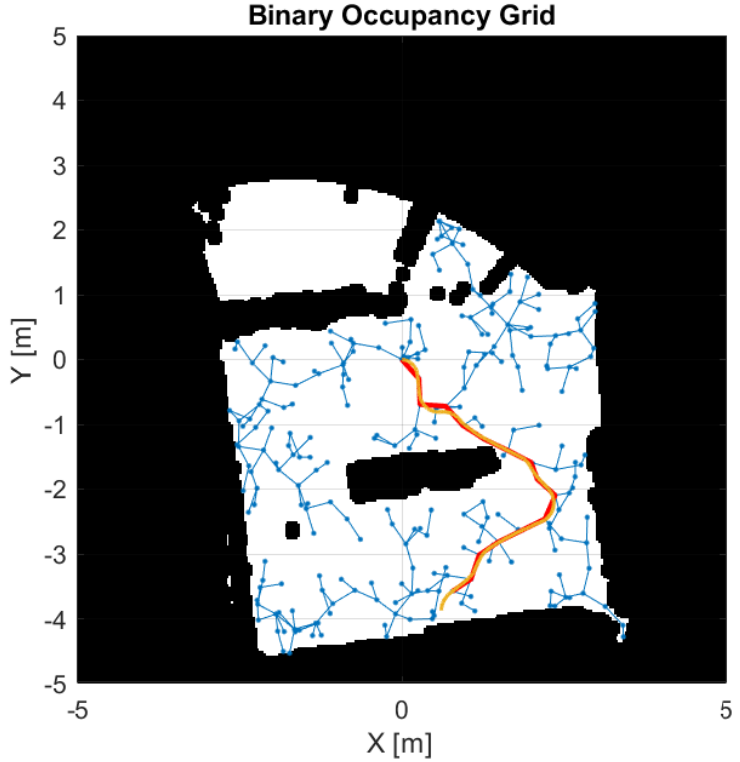
Figure 12. Desired waypoints obtained with RRT star algorithm and path obtained from odometry